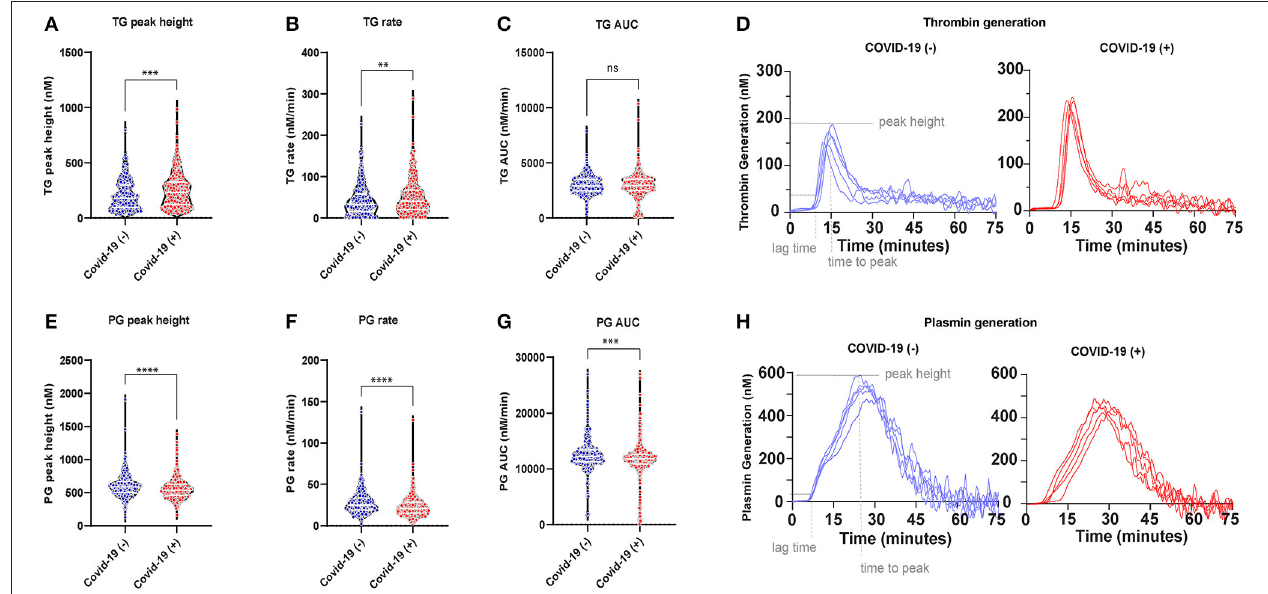
FIGURE 2 | Plasma coagulation in acutely ill COVID-19 ( − ) and ( + ) patients: (A) Thrombin generation (TG) peak height 177.5 (IQR, 94.24–297.6) ( − ), 230.0 (IQR, 23.0–326.2) ( + ), p < 0.0005; (B) TG rate 32.66 (IQR, 15.78–57.69) ( − ), 40.38 (IQR, 20.39–67.33) ( + ), p = 0.0063; (C) TG AUC 2902 (IQR, 2442–3503) ( − ), 2,957 (IQR, 2,486–3,502) ( + ), p = 0.9187; (D) Representative TG curves from patient plasma; (E) Plasmin generation (PG) peak height 585.5 (IQR, 497.5–665.5) ( − ), 535.2 (IQR, 458.5–624.3) ( + ), p < 0.0001; (F) PG rate 25.20 (IQR, 19.26–33.69) ( − ), 20.97 (IQR, 15.31–28.57) ( + ), p < 0.0001; (G) PG AUC 12,239 (IQR, 11,277–13,369), 11,783 (IQR, 10,884–26,994), p = 0.0002; (H) Representative PG curves from patient plasma. Data points indicate individual measurements, and p -value comes from the Mann-Whitney analysis for comparison within groups. Values are presented as median and interquartile range (IQR, 25th–75th percentile) for